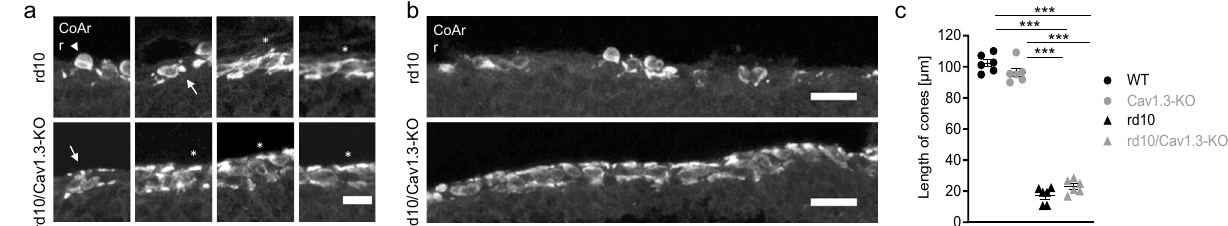
Figure 3. Cone morphology in the central retina at P45. ( a) Cone outer segments were observed in variable forms in both rd10 and rd10/Cav1.3-KO strains as shorter (asterisks), circular (arrows) and absent (arrowheads). (b) Cone soma organization in rd10 and rd10/Cav1.3-KO retinas in the central region. (c) The length of 20 cones within different segments of 300 µm linear length of central retinas was measured [in µm]: wild type (WT): 102.3 ± 2.3; Cav1.3-KO: 96.4 ± 2.8; rd10: 17.2 ± 2.1; rd10/Cav1.3-KO: 22.9 ± 1.8. N = 6 for all strains. Statistics: *** p < 0.001. One-way ANOVA with Holm-Sidak’s multiple comparison test. Data are presented as means ± SEM. Scale bars: 10 µm ( a ), 20 µm ( b ).